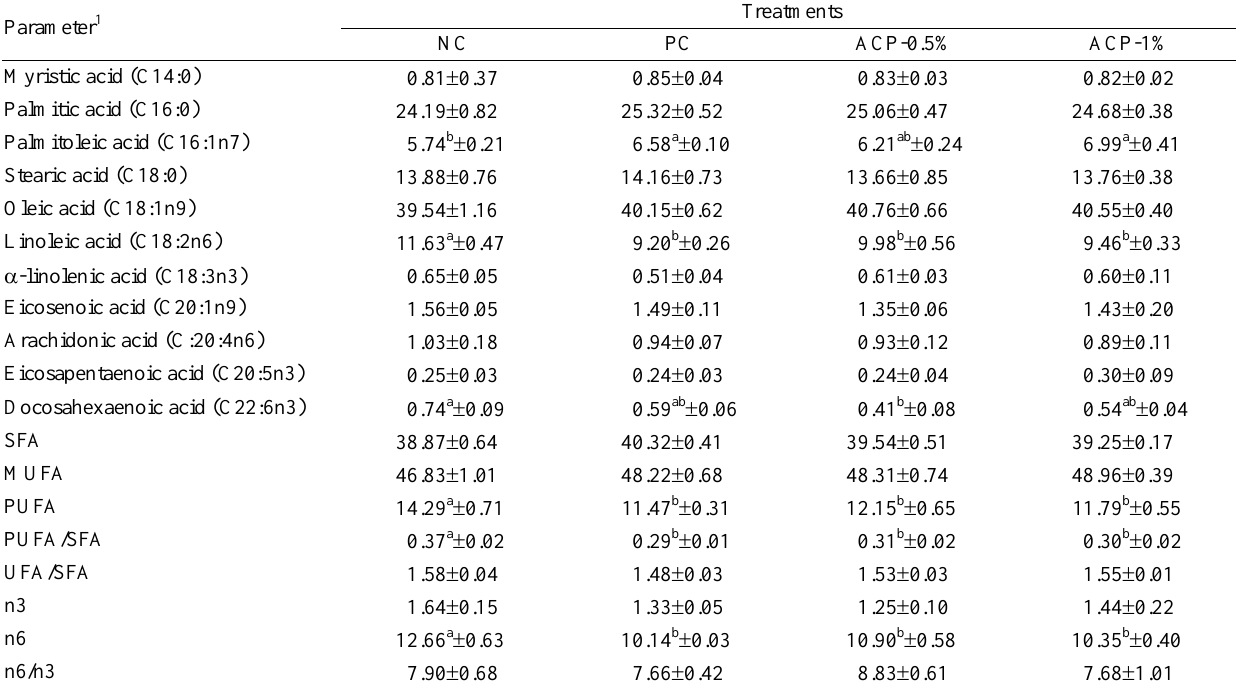
Table 7. Effect of Alisma canaliculatum with probiotics on fatty acid composition of thigh meat (g/100 g total fat) (n = 15 for each